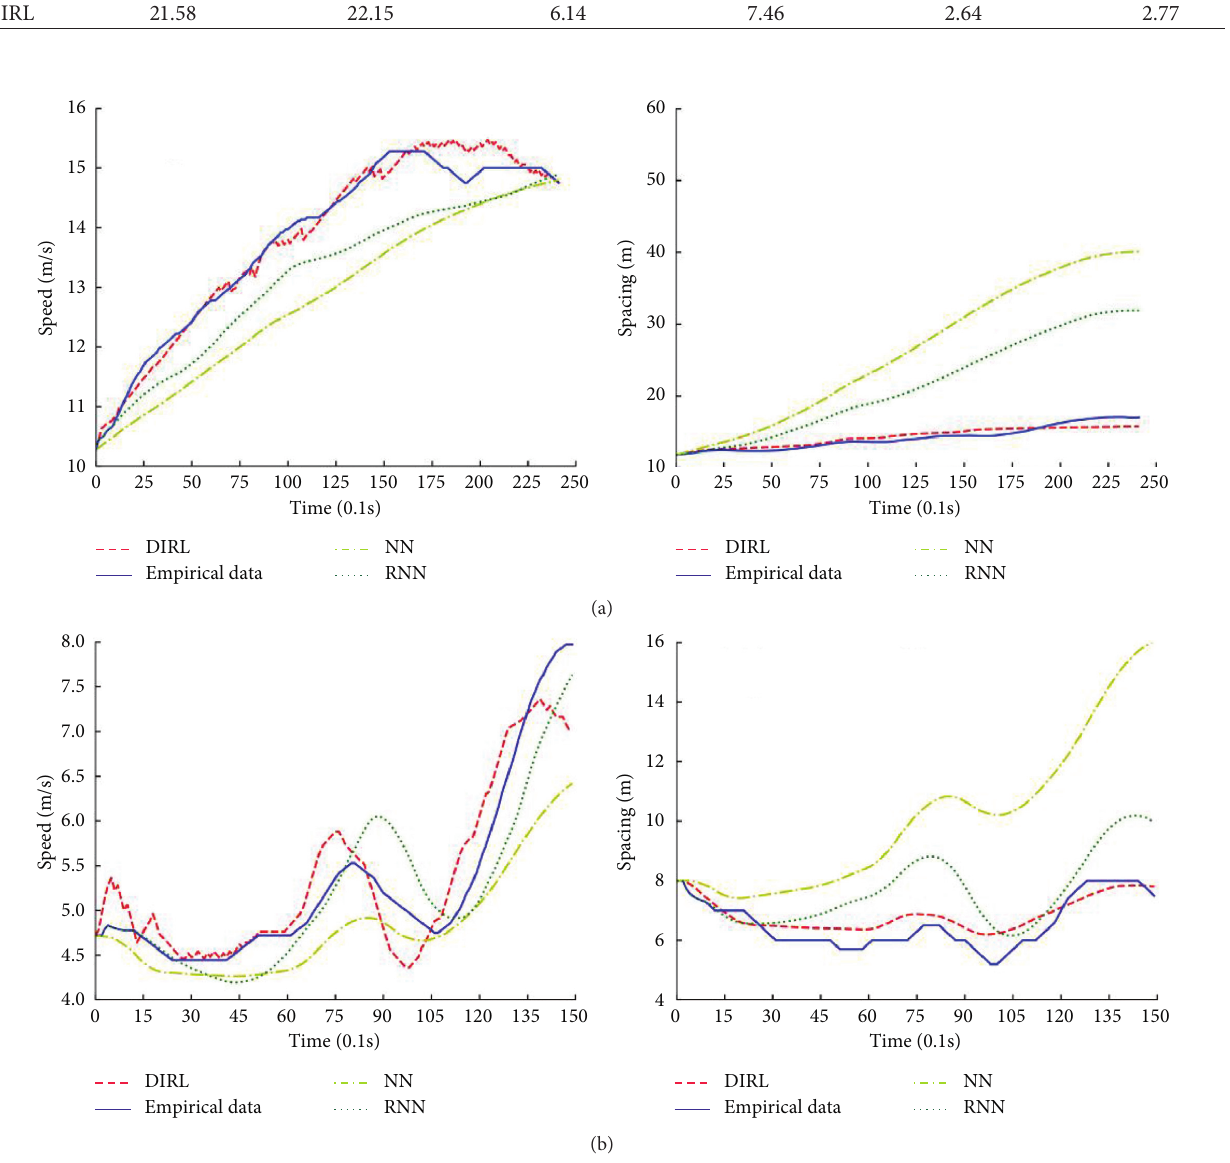
Figure 8: The simulation results of speed (left) and spacing (right) for two car-following periods (a) and (b) by different models.